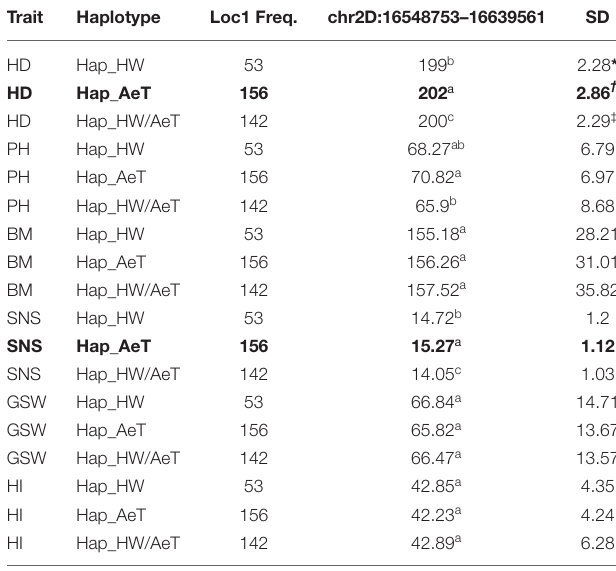
TABLE 4 | ANOVA for the effect of Ppd-D1 haplotype variants from hexaploid wheat and A. tauschii on the spikelet number per spike (SNS) in three experimental trials of the introgression population.